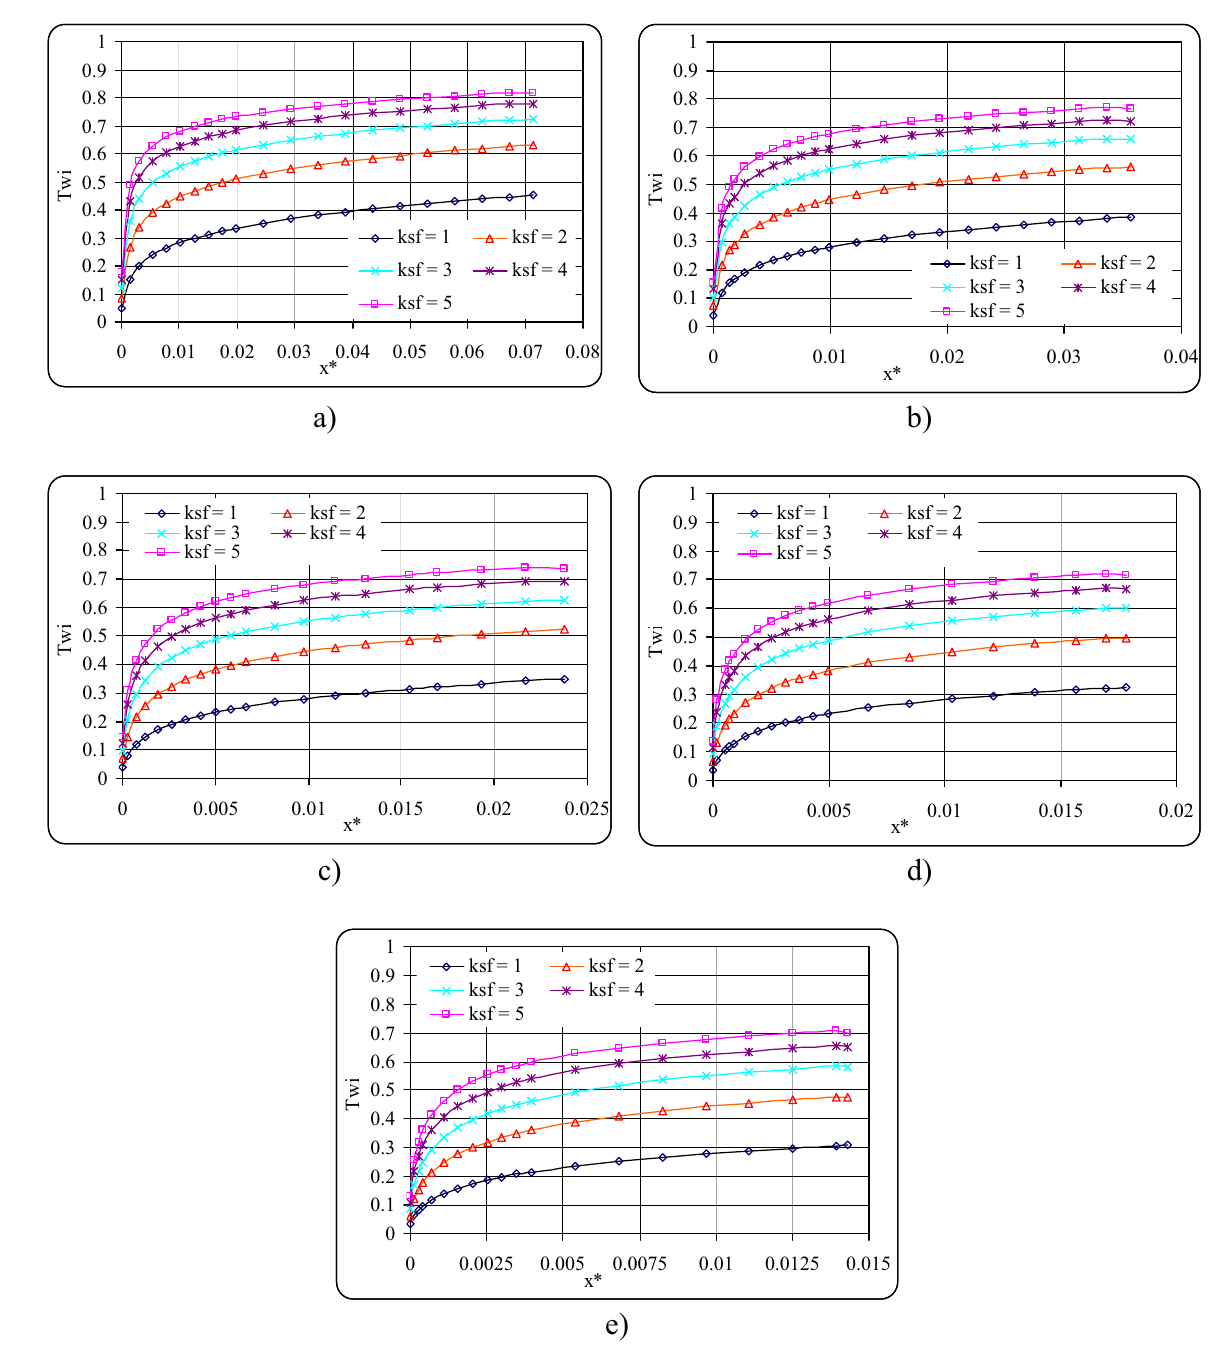
Figure 6: Relationship between dimensionless inside wall temperature vs dimensionless axial coordinate δ /R i = 1 and Pr = 7, with variable ksf ratio. ( a ) Re = 200, ( b ) Re = 400, ( c ) Re = 600, ( d ) Re = 800, and ( e ) Re =